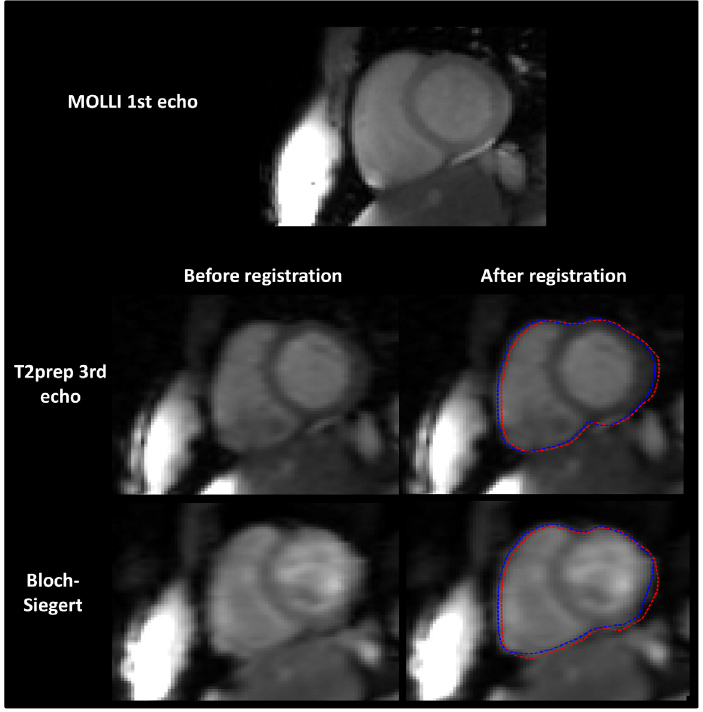
Fig 7. Typical images acquired in vivo on one healthy volunteer with the MOLLI, T2-prepared b-SSFP and Bloch-Siegert sequences. Contours of the heart were manually drawn before and after rigid registration (red and blue dashed lines respectively) and overlaid on the registered